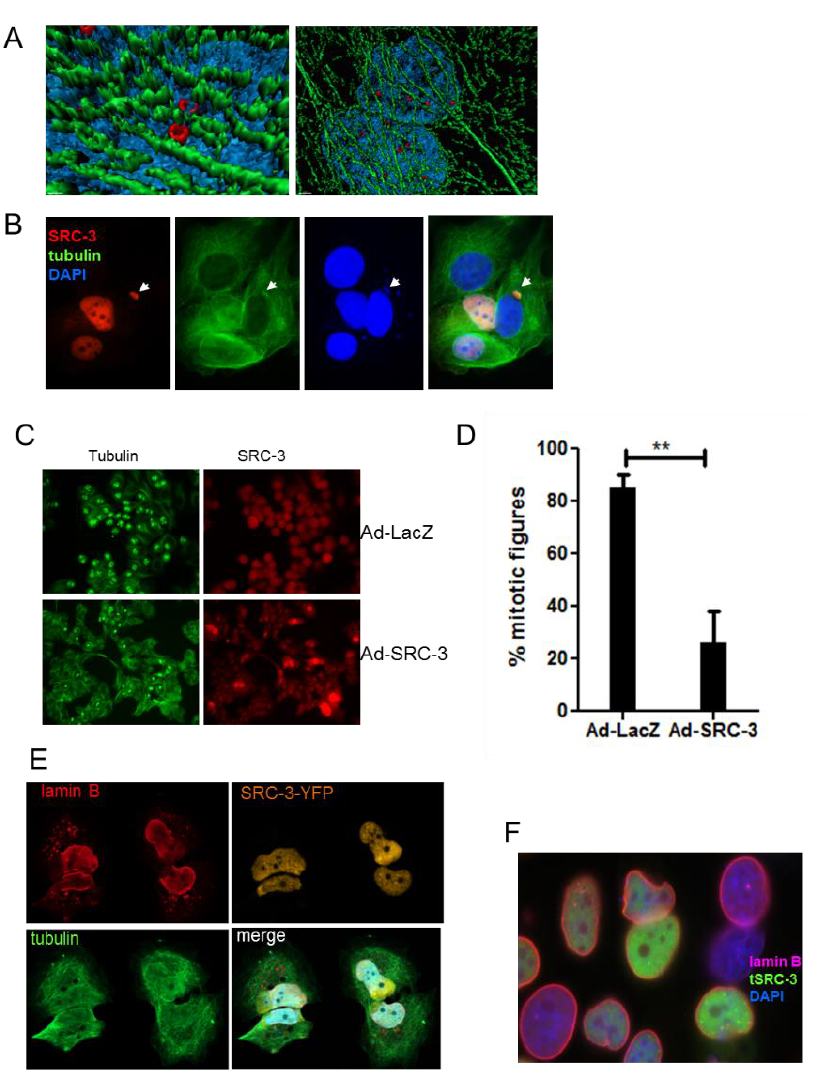
Figure 5. SRC-3 aggregates are associated with microtubules, redistribute PML and SUMO and compromise nuclear membrane integrity. ( A ) 3D deconvoluted model constructed as described in Materials and Methods using Z-stacks acquired with confocal microscopy from SRC-3-transfected cells and immunostained for SRC-3 (red) and β -tubulin (green) and imaged. Blue is DAPI (100 × magnification). ( B ) Immunofluorescence of β -tubulin (green) and SRC-3 (red) showing regions of increased perinuclear tubulin density in SRC-3 overexpressing cells. Nuclear protrusion of SRC-3 and DNA (blue) are indicated with arrows (63 × magnification). ( C ) SRC-3 expression interferes with mitotic microtubule dynamics. MCF-7 cells were infected with Ad-LacZ or Ad-SRC-3 on coverslips and 48 h later were treated with taxol for 18hrs and IF performed to detect mitotic microtubules and SRC-3 (63 × magnification). ( D ) Cells treated in C were enumerated for the presence of mitotic figures. Bars are S.D., ** p < 0.01. ( E ) Z-stack images of cells transfected with SRC-3-YFP and immunostained for lamin B1 (red) and tubulin (green) immunofluorescence showing nuclear membrane distortion, and degradation associated with cytoplasmic SRC-3 aggregates (100 × magnification). ( F ) IF of lamin B1 in SRC-3-GFP-transfected cells showing cells with discontinuous nuclear membranes, lamin B1 fragments, and distortions of nuclear shape. nucleophagy-mediated cell